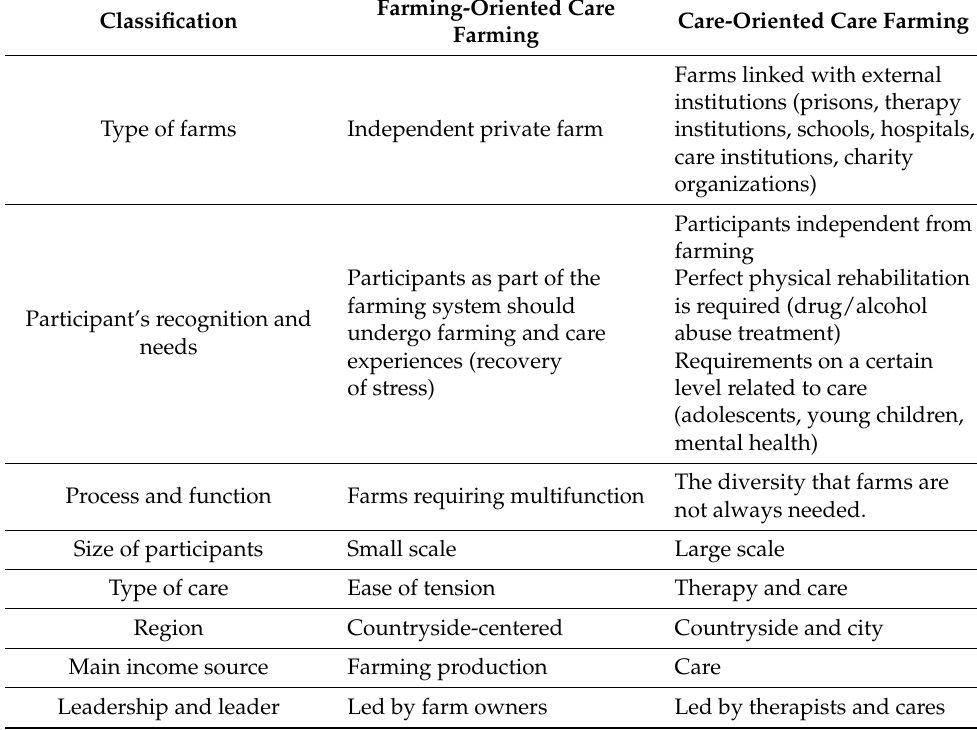
Table 3. Operation of care